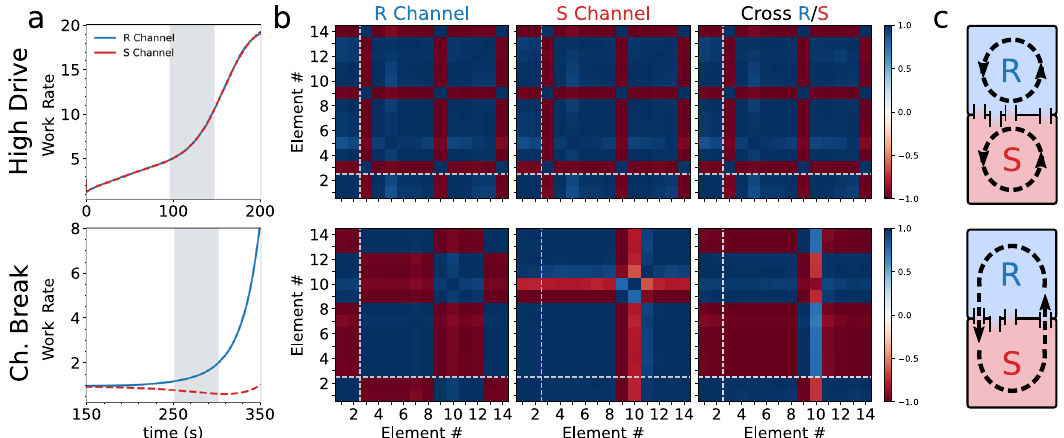
Fig. 4 System correlations. a Work rates (i.e., power) for a high drive system (top) and the chiral-breaking model of Fig. 2 (bottom). b Concentration correlation matrices between all achiral (1 – 2) and chiral (3 – 14) elements of each corresponding R or S channel over a period of 50 s (shaded areas in ( a )). Dashed light-colored lines denote achiral-chiral element correlation boundaries. Correlation time ranges are chosen to be at comparative timescales of the bifurcation horizon for the chiral-breaking system and the onset of strong drive in the chiral-conserving model. Third matrix column shows the cross- channel concentration correlation where rows(columns) correspond to the R ( S ) channel elements. Color bar denotes maximum and minimum values for all matrices, with + ( − )1 indicating perfect positive(negative) correlation. c Schematic of channel correlations symbolized by counter-clockwise cycles indicating a strong matching of the system to the environmental drive. For the chiral-conserving case, these are separate and equal (top) but system-wide for the chiral-breaking model (bottom). For a more detailed illustration of the chemical network during this period, see Supplementary Figs. 10 and